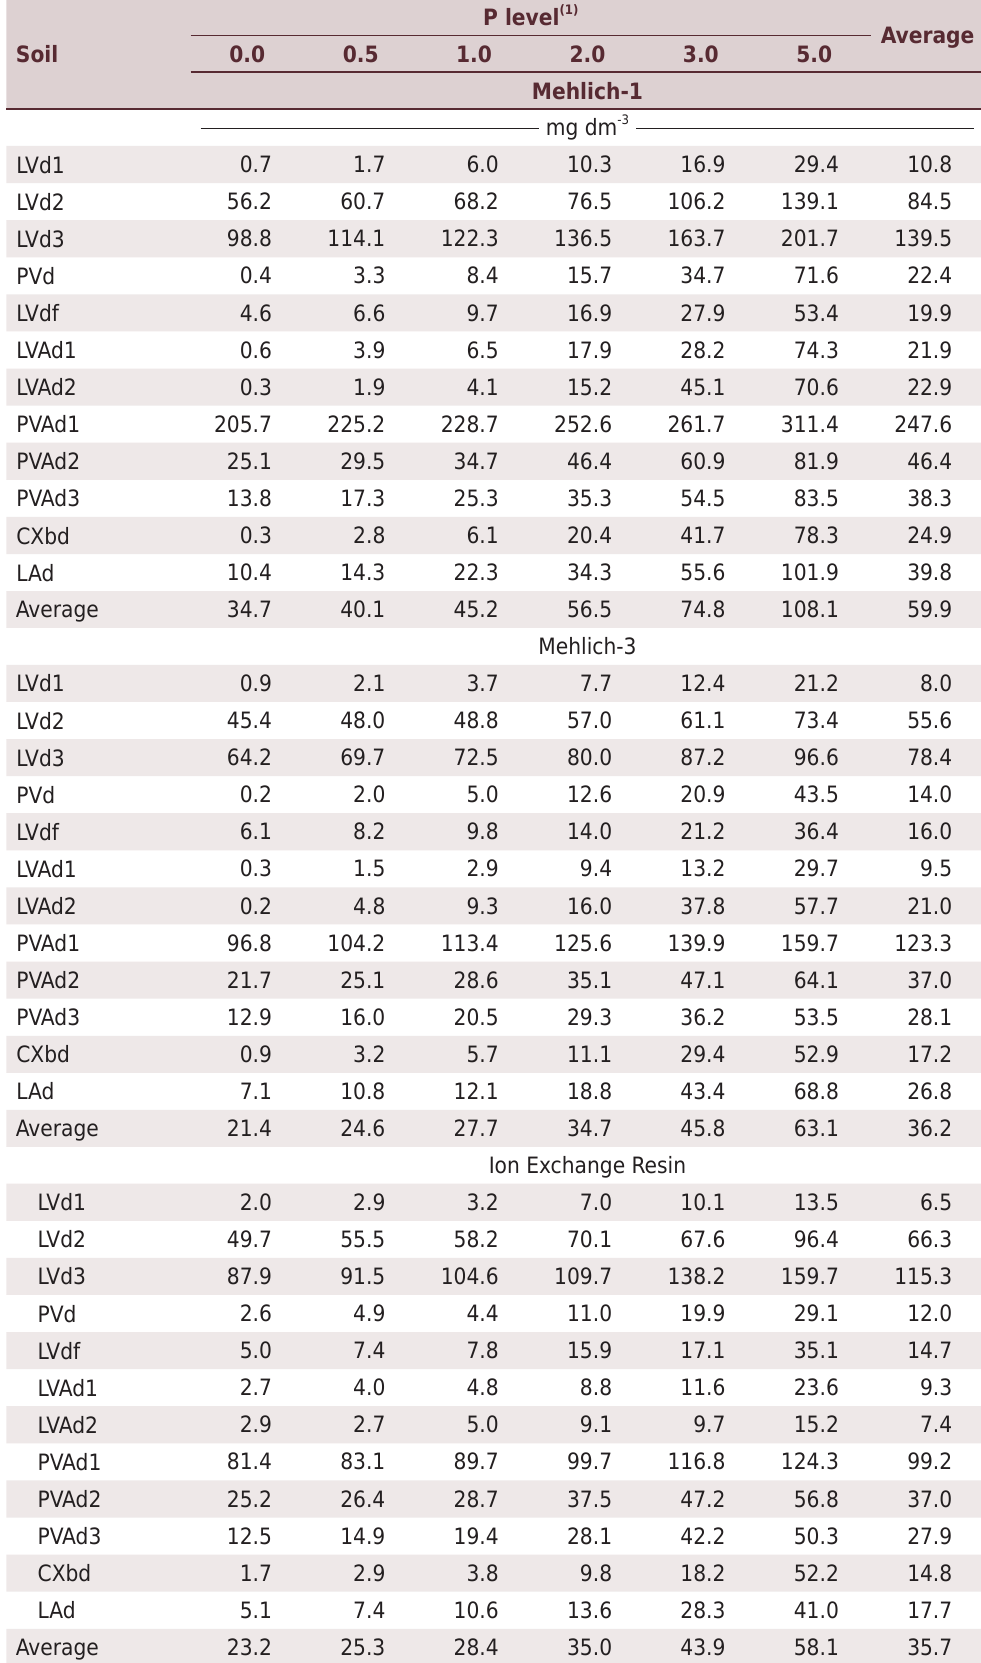
Table 2. Soil available P by Melich-1, Mehlich-3, and Ion Exchange Resin extractants as a function of the doses of P applied to each soil